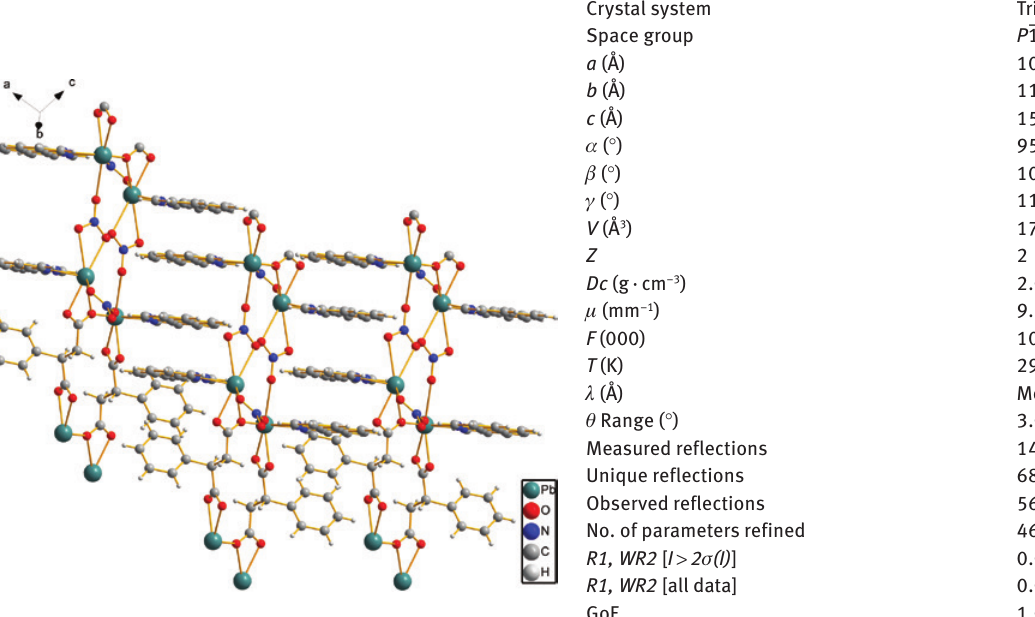
Figure 3: Supramolecular structure of the CP highlighting the π – π interactions between the phenanthrolin ligands.